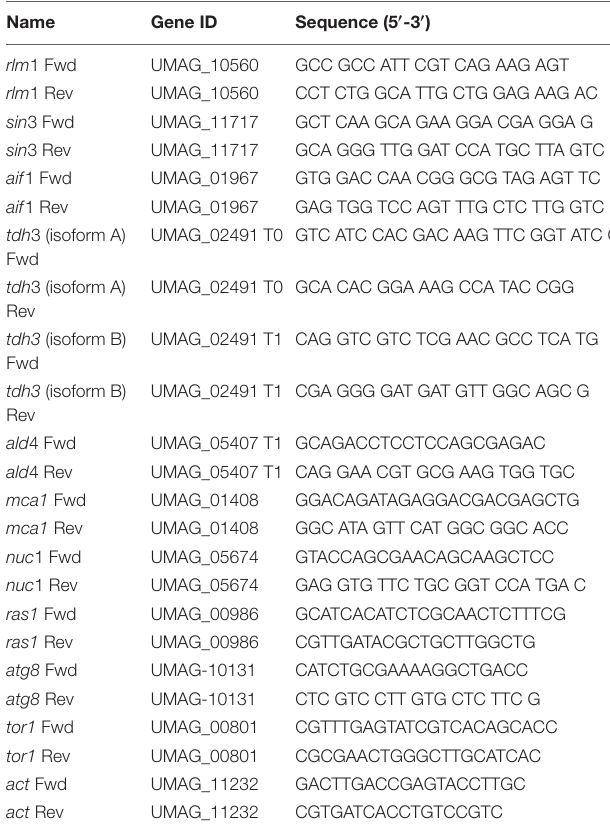
TABLE 1 | Sequences of forward and reverse primers used for qRT-PCR